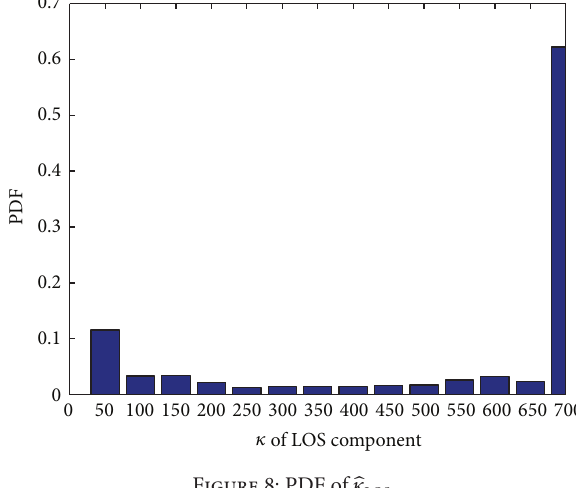
Figure 8: PDF of ̂𝜅